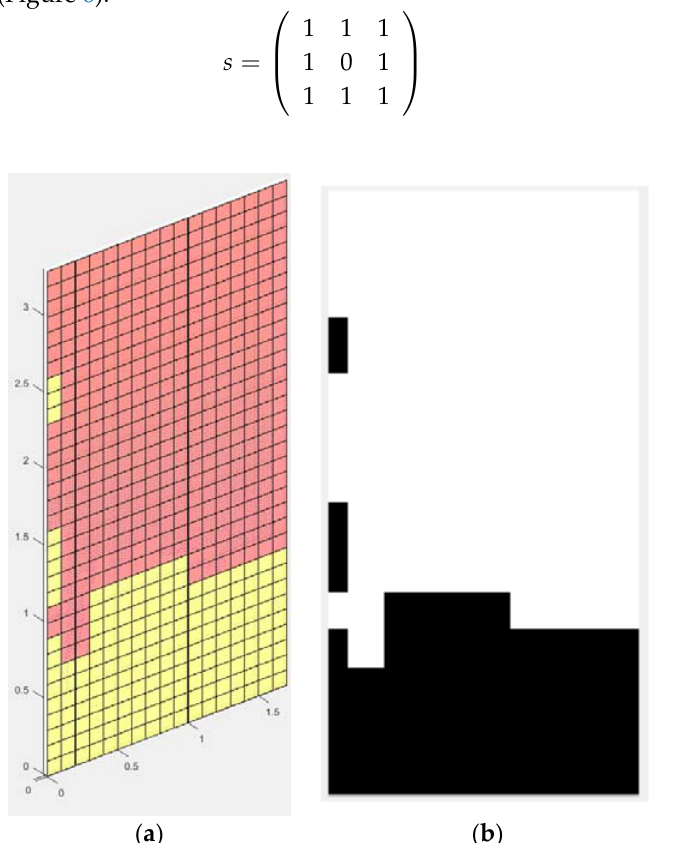
Figure 4. ( a ) Wall discretized (red: occupied; yellow: empty) (in meters); ( b ) Binary image of the discretized wall (right).